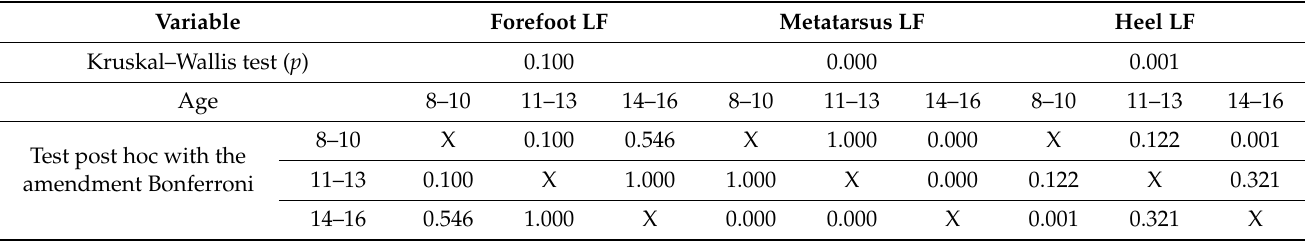
Table 3. Significance of differences in parameters of the distribution of pressure forces in the left foot between the studied age